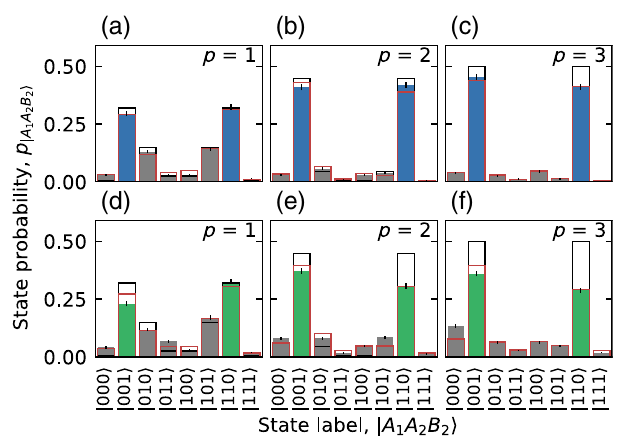
FIG. 4. Output state probability distribution for the three-qubit problem instance implemented with controlled arbitrary phase gates (a)–(c), and decomposed using C Z gates (d)–(f). States are measured at optimal parameters for depths of p = 1 (a),(d), p = 2 (b),(e), and p = 3 (c),(f). The filled bars correspond to the measured state probabilities in which we highlight the problem solutions in blue (direct implementation) and green (decom- posed implementation), respectively. The black wireframes are the expected QAOA outcome from noise-free simulations and the red wireframes are from master-equation simulations. We use 15000 individual measurement runs to estimate each probabil- ity distribution. The black vertical markers indicate a bootstrap 99.7% confidence interval [39] for each state, estimated from the bootstrap standard deviation of 100 resampled datasets of the original single-shot